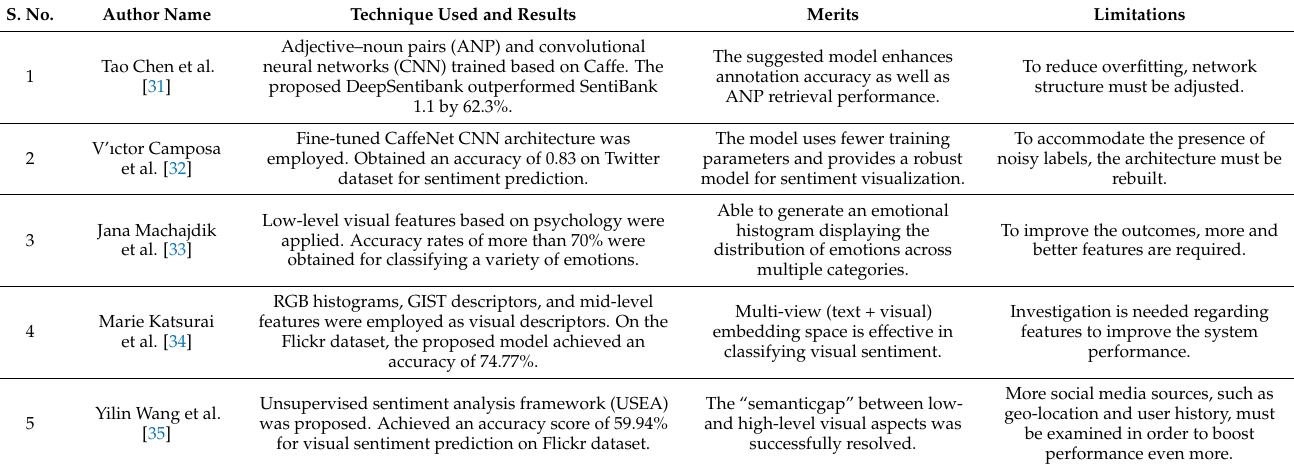
Table 1. Existing works on visual sentiment prediction based on low, mid, and deep visual